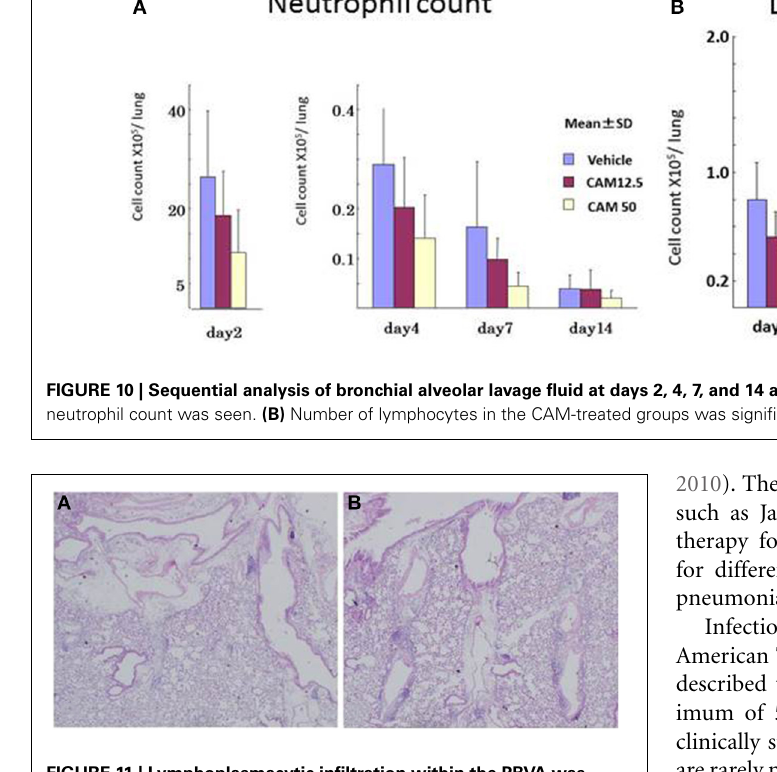
FIGURE 11 | Lymphoplasmacytic infiltration within the PBVA was markedly suppressed in the (A) CAM50 group as compared with the (B) vehicle group. PBVA, peribronchovascular